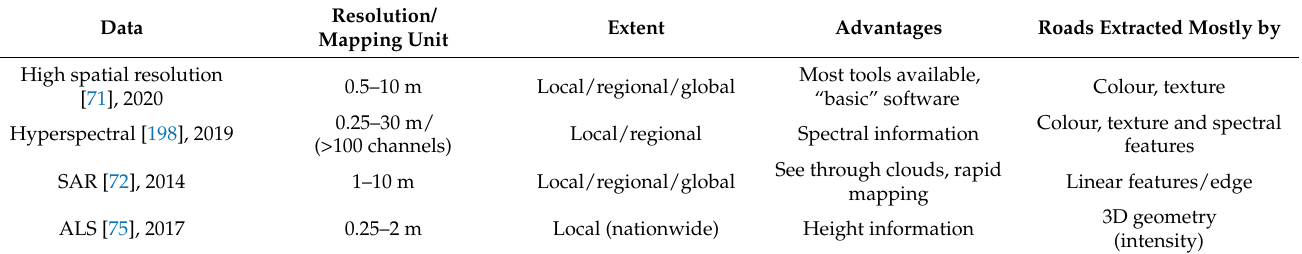
Table 8. Summary of road extraction based on different data